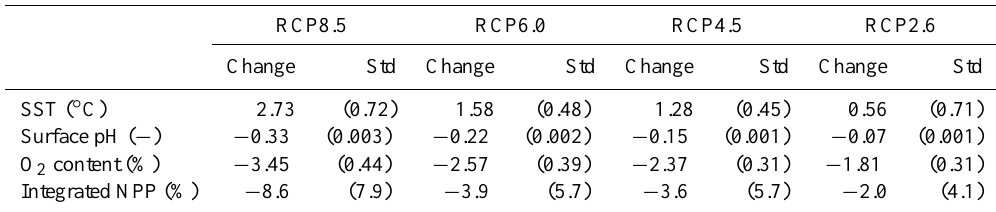
Table 3. Evolution of SST, pH, global O 2 , integrated NPP for all models and all scenarios. Model means in 2090–2099 (compared to 1990–1999) and inter-model standard deviations in